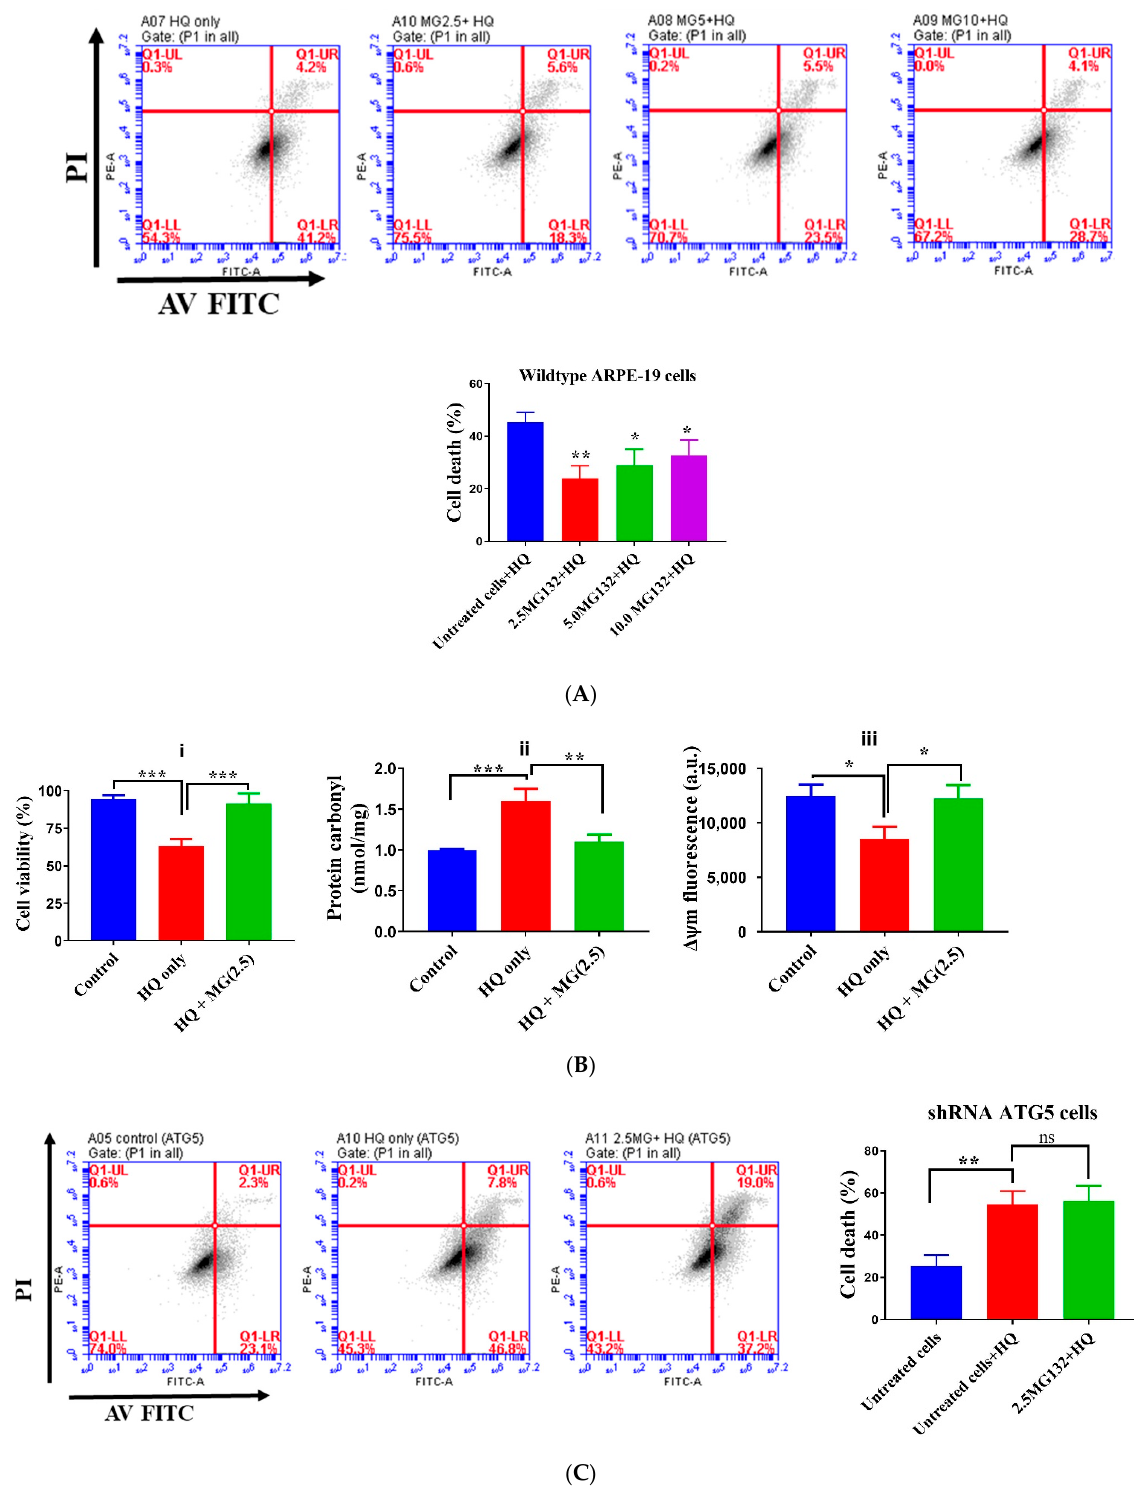
Figure 8. MG132 protects against hydroquinone-induced oxidative damage and apoptosis in autophagy competent